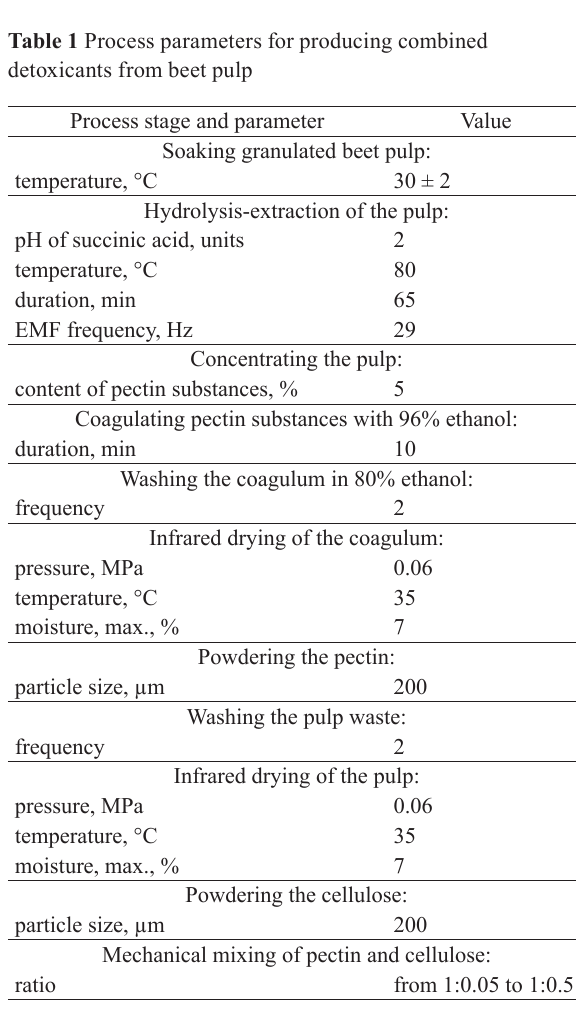
Figure 7 The complexing (binding) capacity of a combined detoxicant with respect to lead ions (Pb 2+ ) depending on its qualitative composition